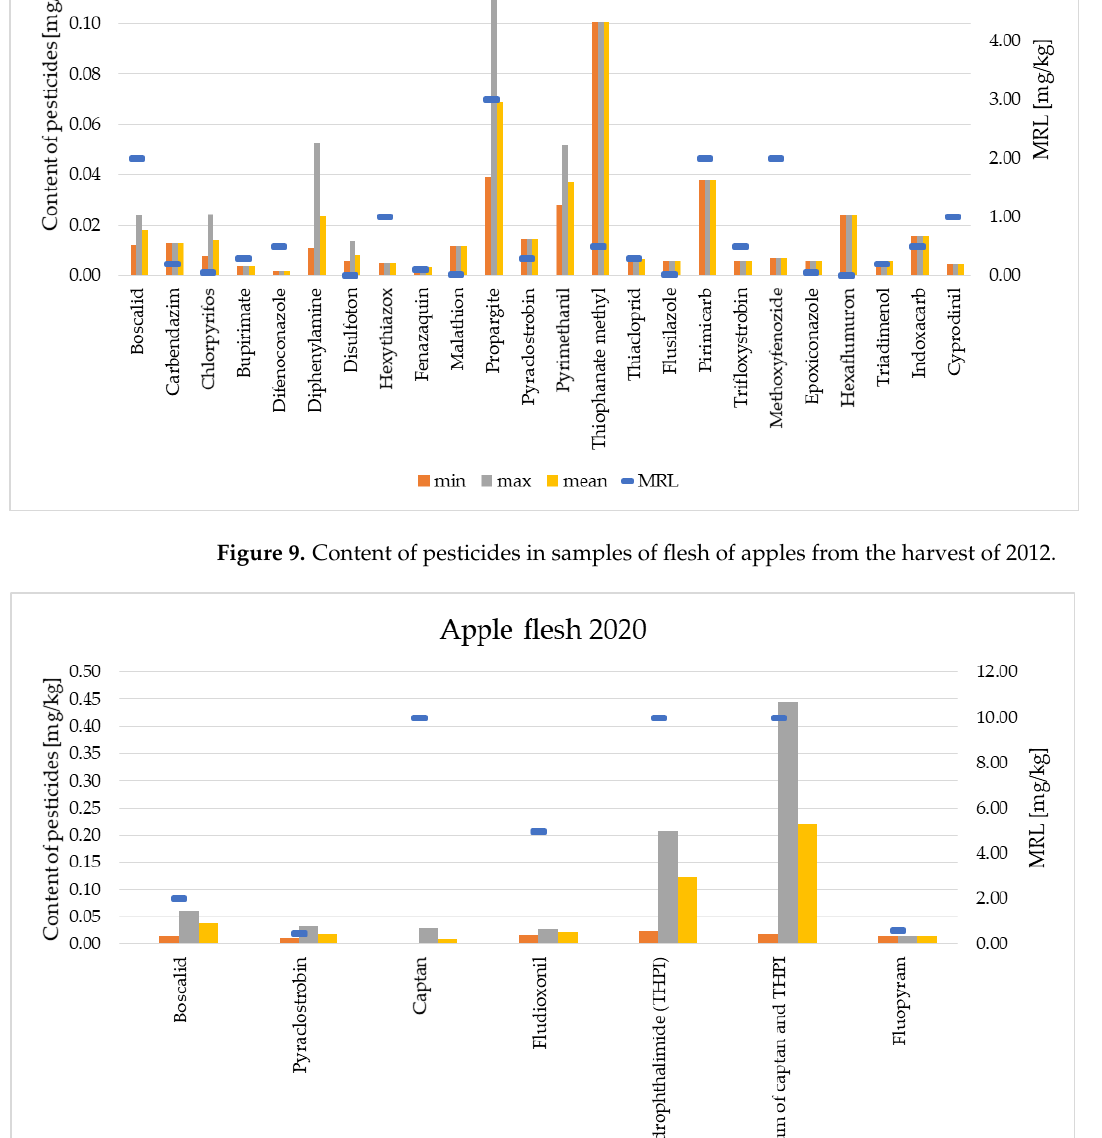
Figure 10. Content of pesticides in samples of flesh of apples from the harvest of 2020.